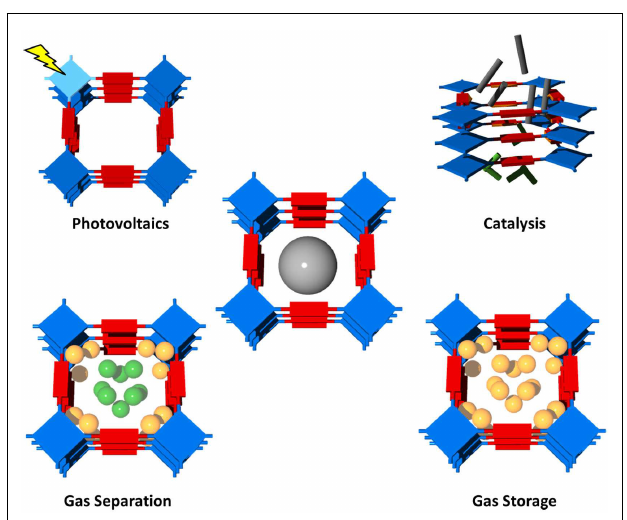
FIGURE 1 | Summary of applications for covalently linked organic networks .